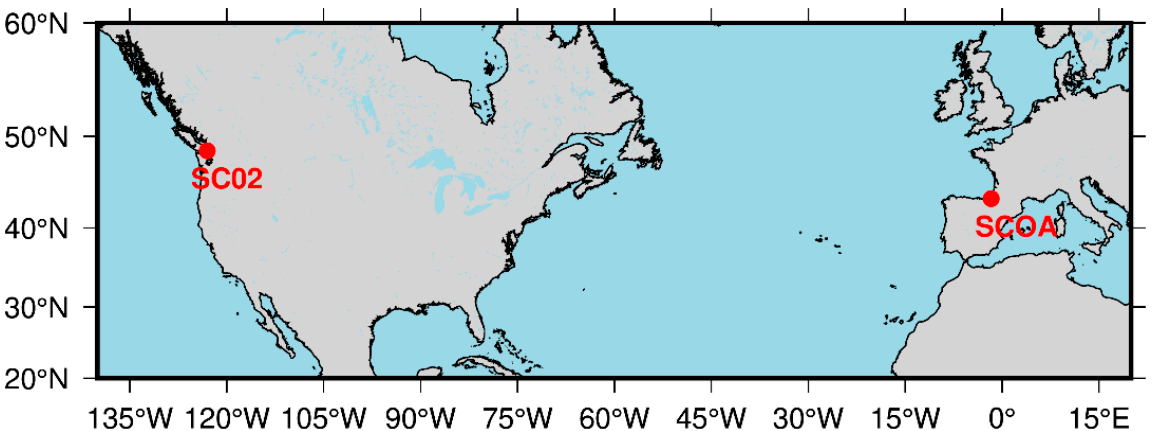
Figure 1. Location of two GNSS reference stations. Both SC02 and SCOA are operated by the EarthScope Plate Boundary Observatory (PBO, https://www.unavco.org/data/gps-gnss/gps- gnss.html (accessed on 22 July 2022)) [ 33 ] and Institut National de L’Information Géographique et Forestière (IGN), respectively.